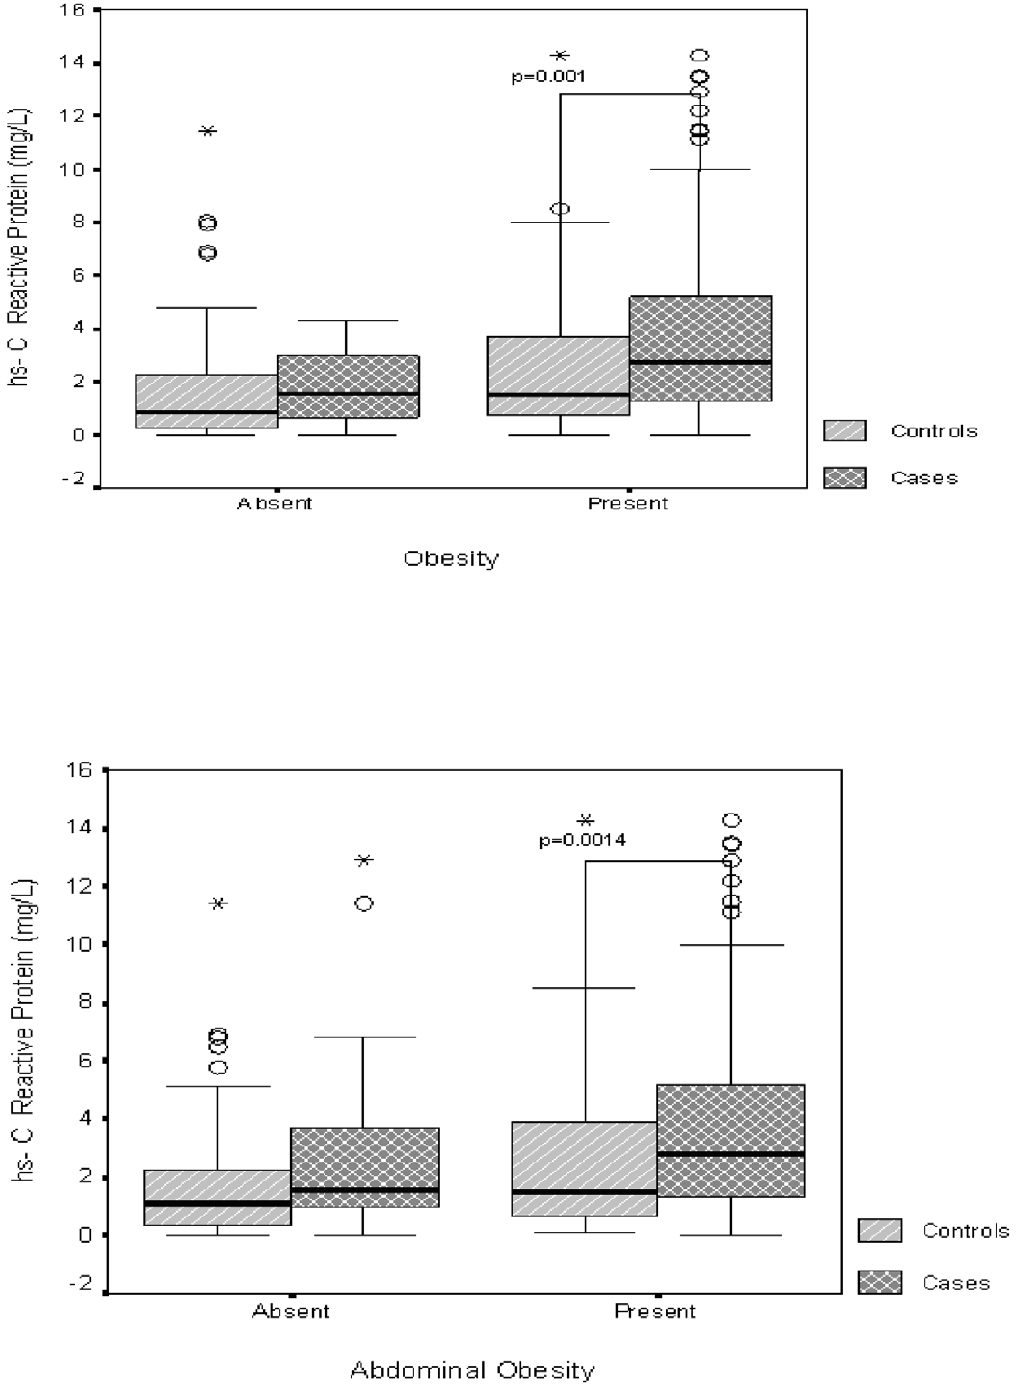
Figure 1. Box plot representation of hs-CRP levels in subjects with non-alcoholic fatty liver disease and in controls having overweight and obesity (a), abdominal obesity (b), and the metabolic syndrome (c). Each box comprises the values between the 25 th and the 75 th percentiles, and the bold horizontal line is the median value; the whiskers stretch from the 10 th and to the 90 th percentile. Circles represent individual outlier’s value. Stars represent extremes value of individual. doi:10.1371/journal.pone.0049286.g001 weight- to-height ratio, mid-thigh circumference, FBG, TC, TG, The median (range) of hs-CRP (mg/dL) for cases [2.6 (0.2– LDL-c, AST and ALT were recorded in cases than in controls 13.4)] was significantly higher than controls [1.4 (0.03–11.4), p (Table 3). value =0.01] (Table 3). Similarly, higher values of hs-CRP were obtained when subgroups of cases and controls with obesity,